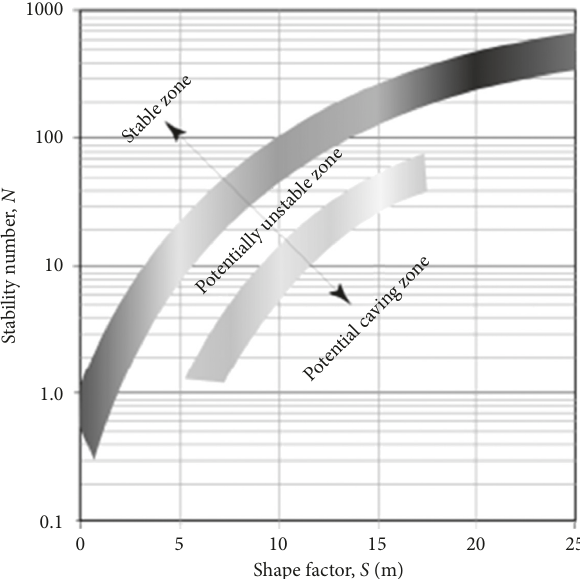
Figure 4: Three stability zones of the original Mathews stability